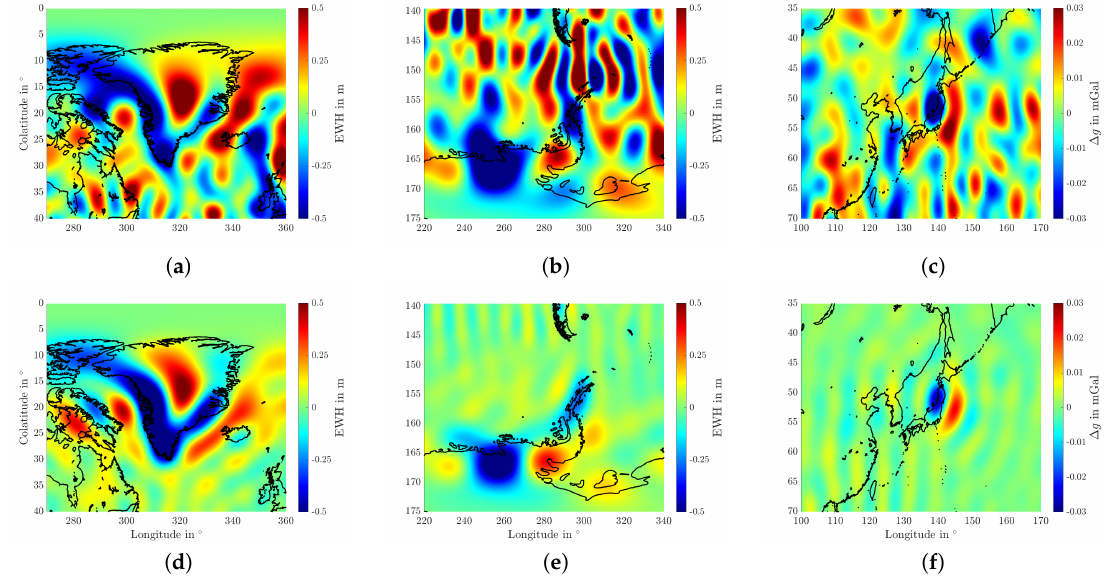
Figure 11. GOCE SGG-only ( a – c ) and GRACE-only ( d – f ; models from in [8]) SH d/o 60 gravity field models, evaluated as regional grids in terms of EWHs in the regions around Greenland ( a , d ) and West Antarctica ( b , e ), and in terms of gravity anomalies ∆ g in the region around Japan ( c , f ). For all panels, the last five bi-monthly gravity field models within the GOCE data period have been averaged on coefficient level according to their standard deviations. The signal computed by evaluating the static and trend part of the GOCO06s model [9] on 1 October 2009 and applying the earthquake correction coefficients (see Section 3.2.1) has been subtracted. Only non-polar gap wedge SH coefficients of degrees 10 to 60 have been used to eliminate the long-wavelength noise in the GOCE